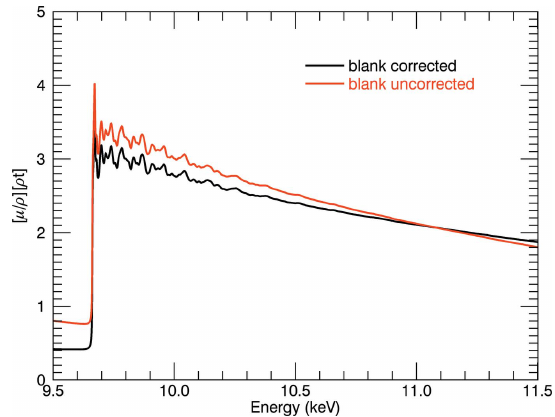
Figure 6 Change in spectra due to blank correction at 10 K for the 10 m m foil. Red: corrected for dark current; black: corrected for blank and dark current, with a reduction of 52.9% pre-edge, and significant change to the slope.